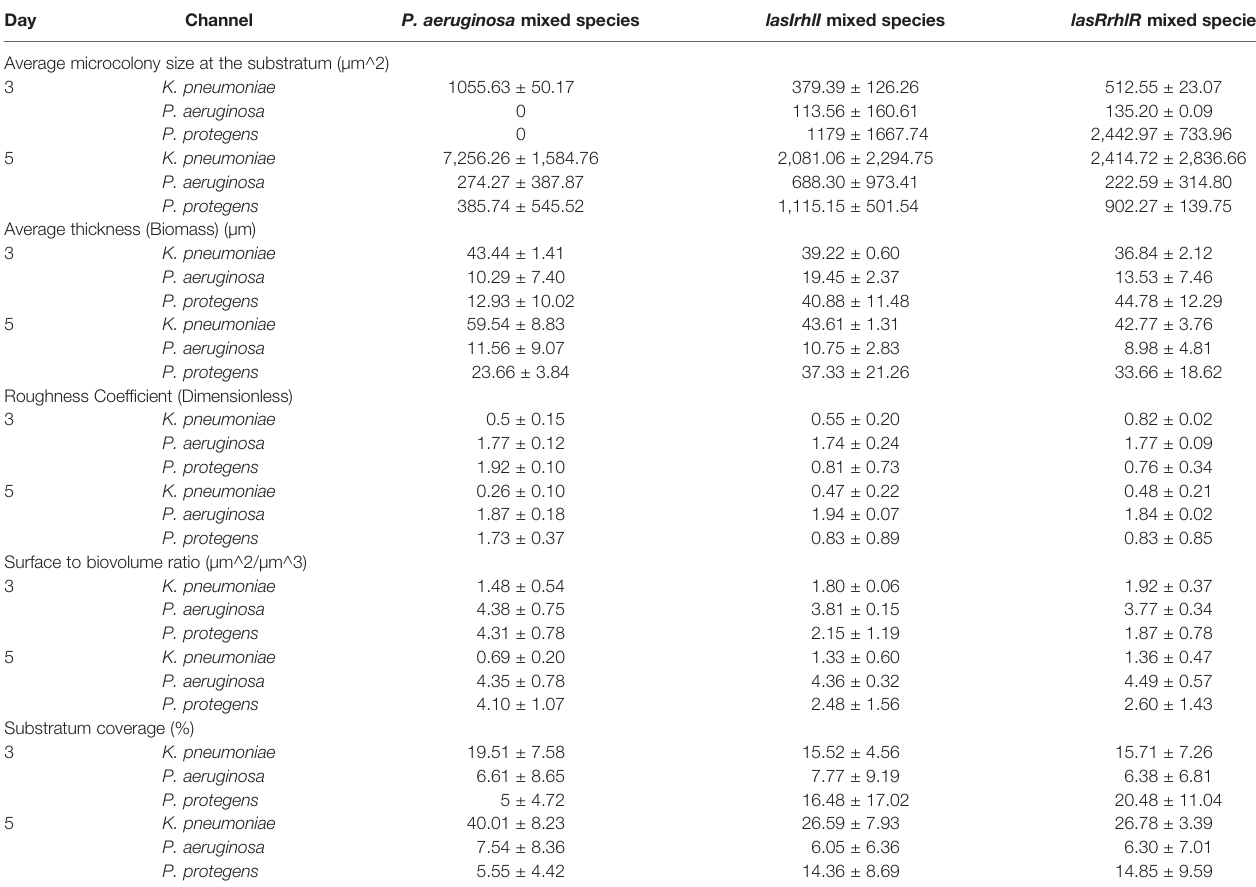
TABLE 2 | Structural features of wild type P. aeruginosa and QS mutant mixed species bio fi lms. Day Channel P. aeruginosa mixed species lasIrhlI mixed species lasRrhlR mixed species Average microcolony size at the substratum (µm^2)